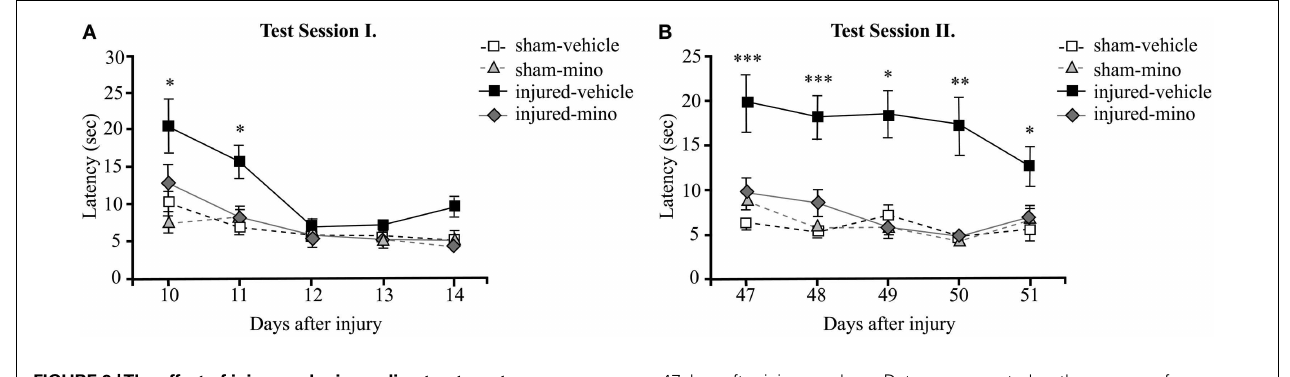
FIGURE 3 |The effect of injury and minocycline treatment on spatial memory at different time points after mbTBI. Latency (seconds) to find and enter the escape box was measured for five consecutive days in the Barnes maze starting at (A) 10days, and (B)